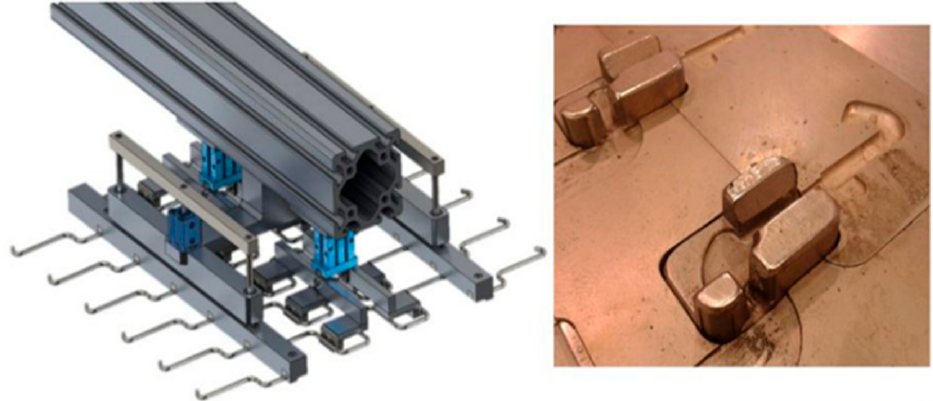
Figure 10. Gripper with two bars and the mold guides with chamfer, respectively.